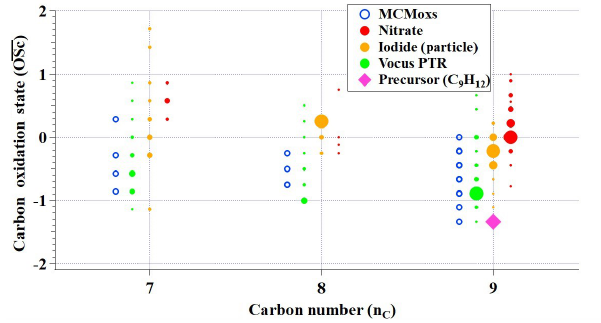
Figure 2. Comparison of C 7 –C 9 products observed in the OH- initiated oxidation of 1,2,4-TMB (Exp. 1 in Table 1) with those listed in the Master Chemical Mechanism (MCM; Bloss et al., 2005). Filled red, orange, and green circles denote observation by the nitrate CI-APi-TOF, iodide CI-TOF, and Vocus PTR, respec- tively, whereas open blue circles represent MCM species. The radii of filled circles are proportional to the signals of the compounds in each instrument. The signal of the most abundant product for each instrument is arbitrarily set to be 100%, but note that the arbitrary signals are not comparable among instruments. Symbols have been offset horizontally to avoid